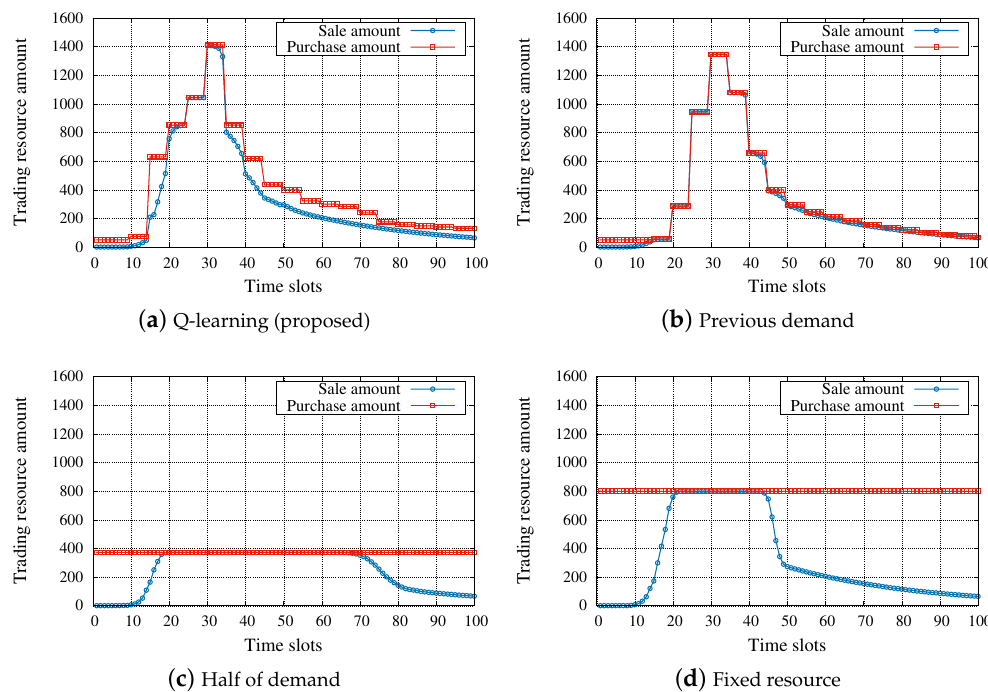
Figure 4. Change of the trading resource amount with respect to the time